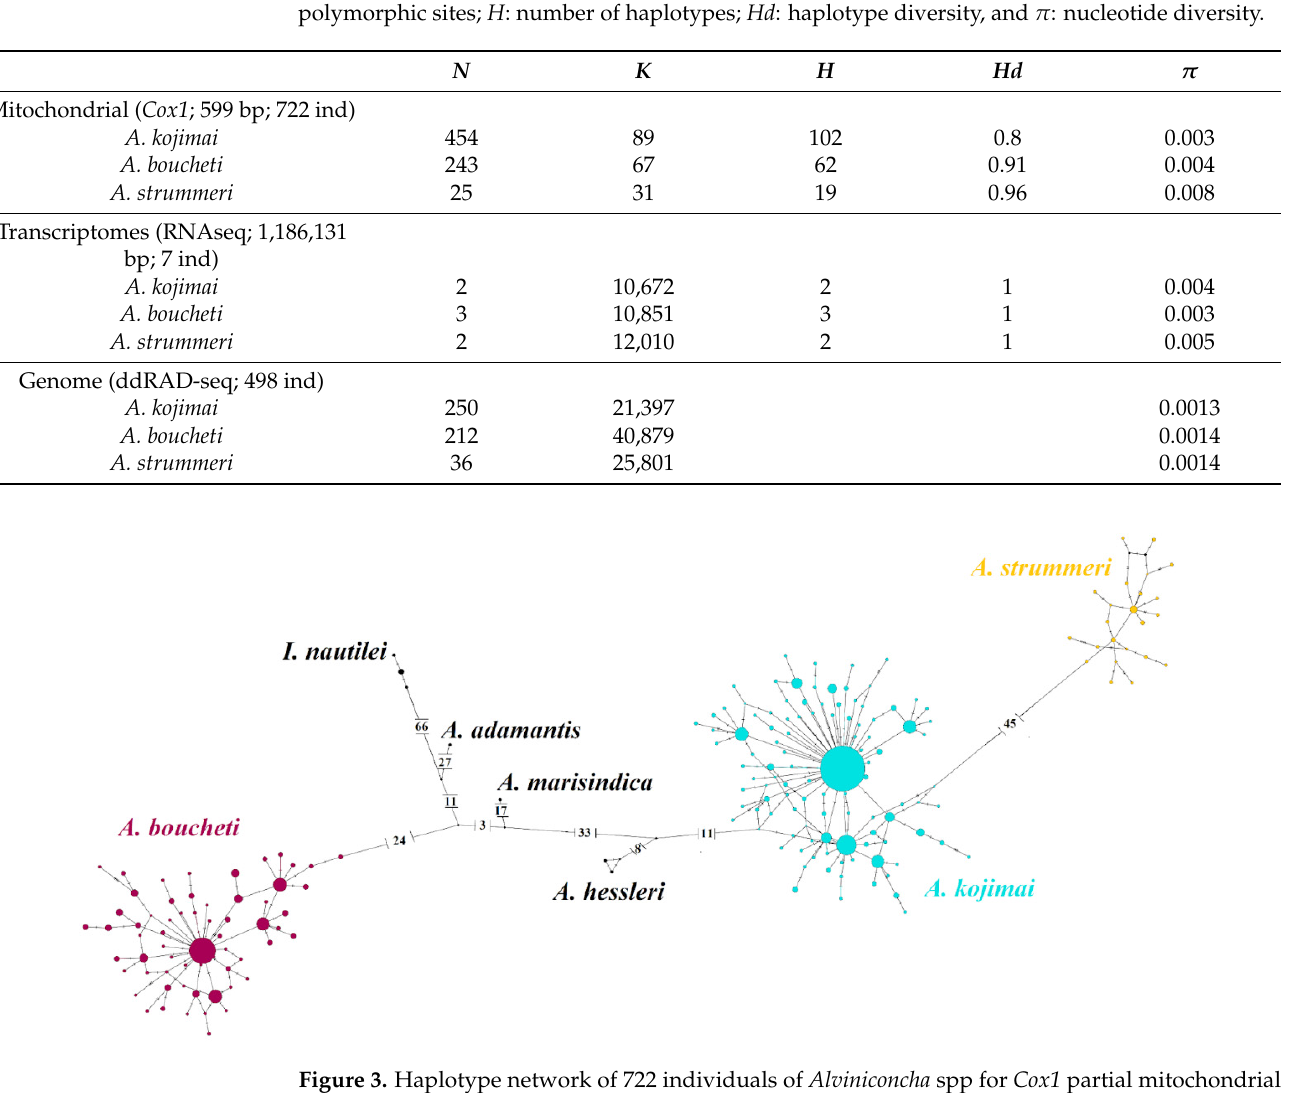
Figure 3. Haplotype network of 722 individuals of Alviniconcha spp for Cox1 partial mitochondrial sequence rooted with Ifremeria nautilei ( n = 4). Circles represent individual haplotypes, while circle size is proportional to haplotype frequency. The numbers on the branches indicate the number of mutations between haplotypes. Purple: A. boucheti ; turquoise: A. kojimai , and yellow: A. strummeri .